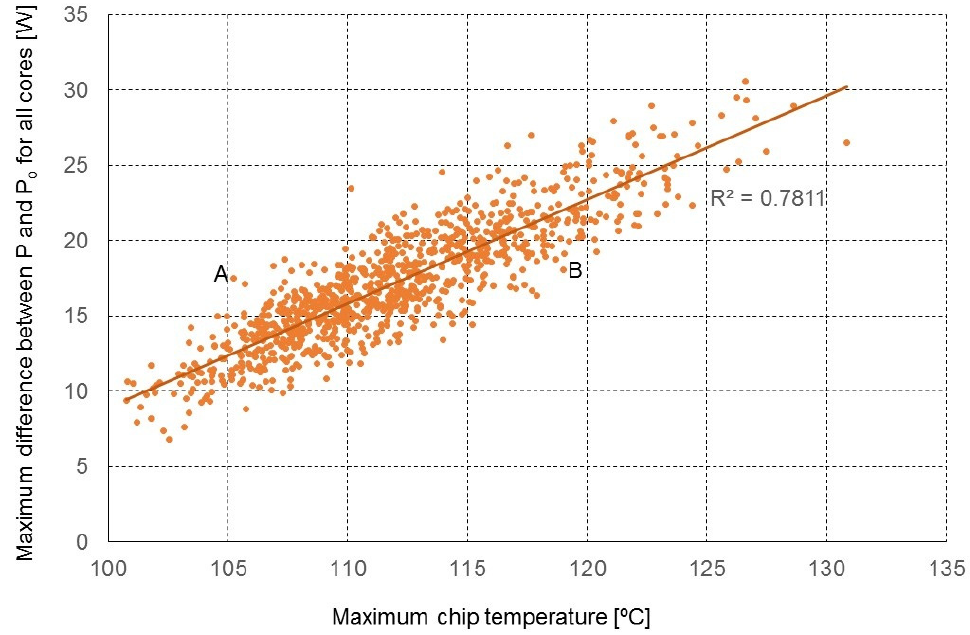
Figure 12. Simulation results of 1000 cases, showing the correlation between the maximum power overhead ( P - P o ) calculated for all cores and the maximum chip temperature.